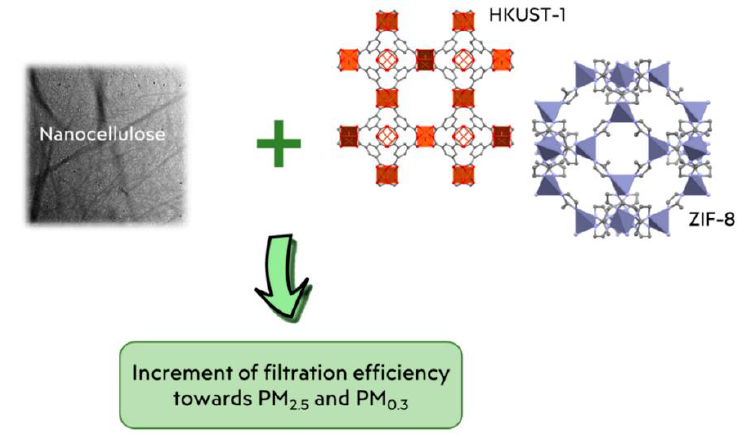
Figure 3. The performance of MOFs for air filtering media [9] .